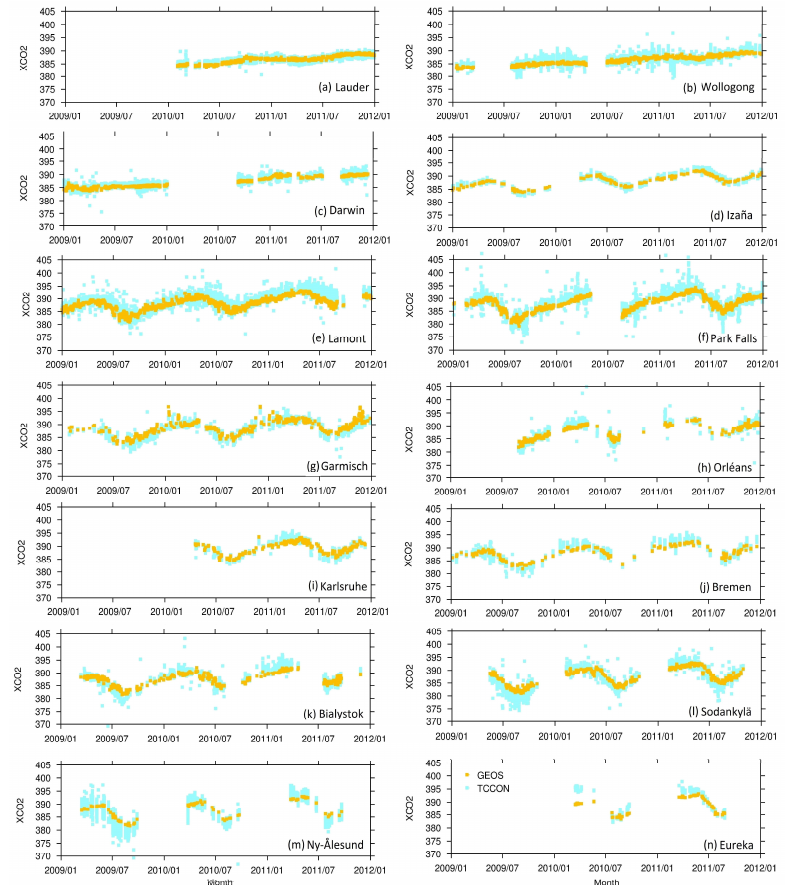
Figure 9. Comparison of XCO 2 from GEOS-Chem (yellow dots) and ground-based TCCON XCO 2 measurements (blue dots) during 2009–2011: ( a ) Lauder; ( b ) Wollongong; ( c ) Darwin; ( d ) Izaña; ( e ) Lamont; ( f ) Park Falls; ( g ) Garmisch; ( h ) Orleans; ( i ) Karlsruhe; ( j ) Bremen; ( k ) Bialystok; ( l ) Sodankylä; ( m ) Ny-Ålesund; ( n ) Eureka.